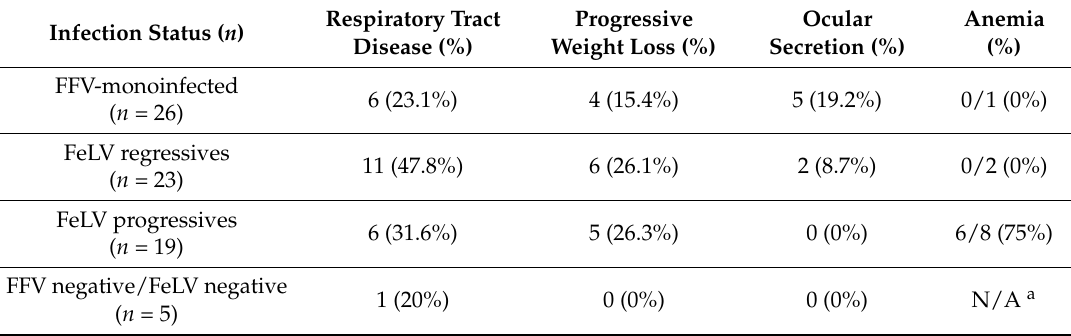
Table 6. Proportion of major clinical symptoms by feline retrovirus infection